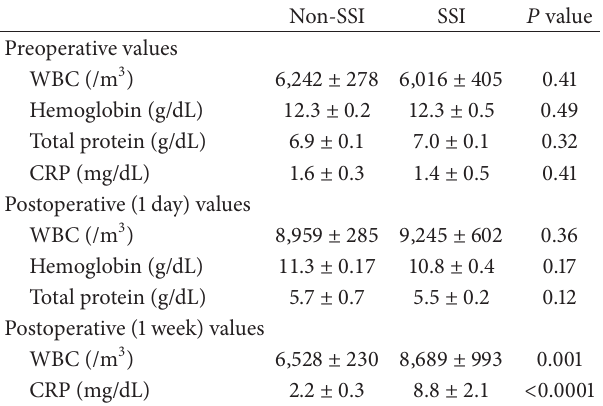
Table 4: Analysis of pre- and postoperative laboratory values. Table 5: Musculoskeletal oncological surgery invasiveness index (MOSI index).